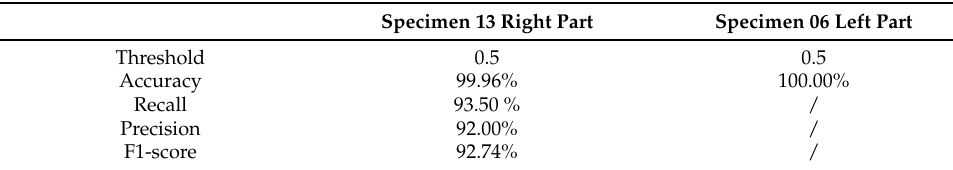
Table 5. Deep model’s evaluation results on MWIR testing data.